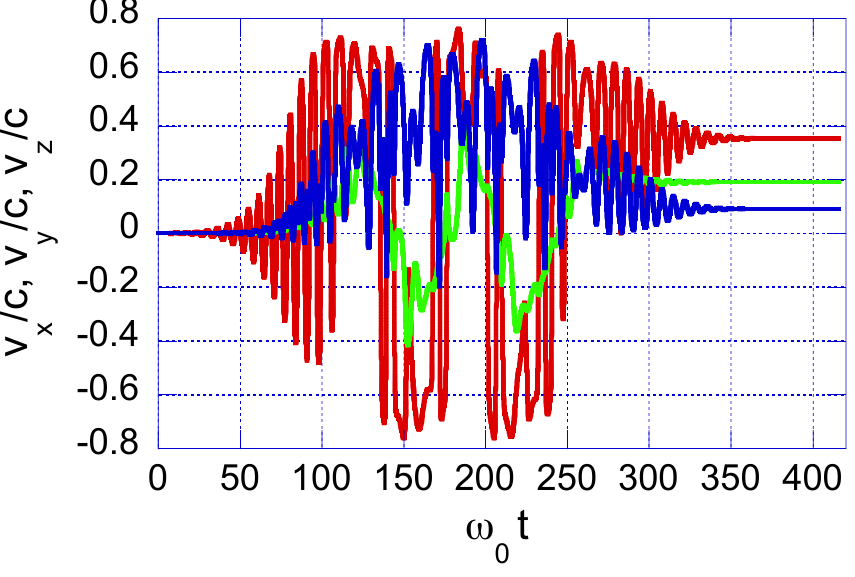
Figure 14. Time evolution of velocity components for x 0 = − 1.60859 µ m, y 0 = − 0.6644 µ m, z 0 = 0. A complex pulsed dynamics is found in this case. After the interaction with the laser pulse the electron acquires non-vanishing asymptotic velocity components on all coordinates axes in general. Color code is red, green and blue for v x / c , v y / c and v z / c respectively. Temporal axis is given as the dimensionless product ω 0 × t